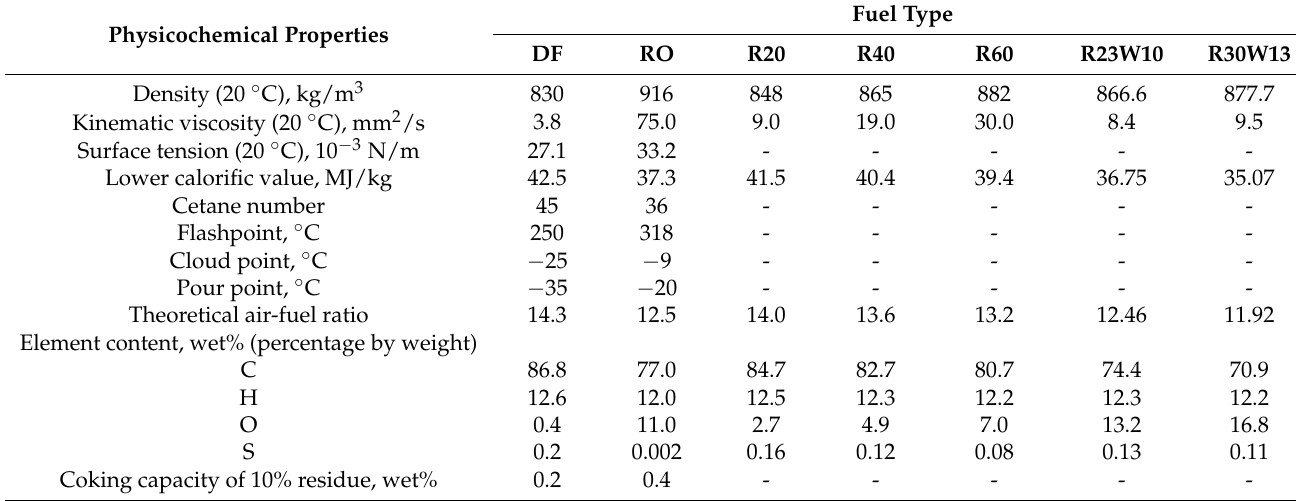
Table 1. Physicochemical properties of DF, RO, DF-RO blends, and water-emulsified DF-RO blends [16,54]. Physicochemical